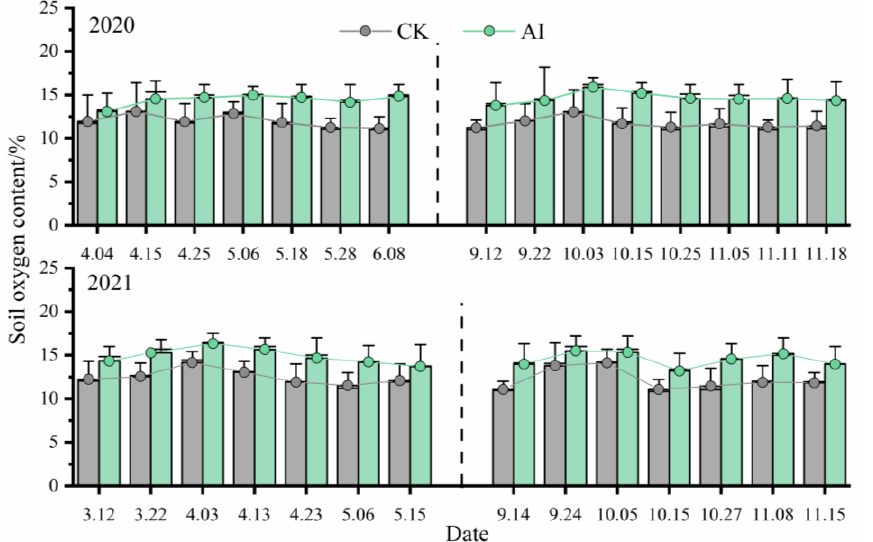
Figure 4. The dynamic change curve of soil oxygen content under different treatments (AI, aerated irrigation; CK, unaerated subsurface drip irrigation).